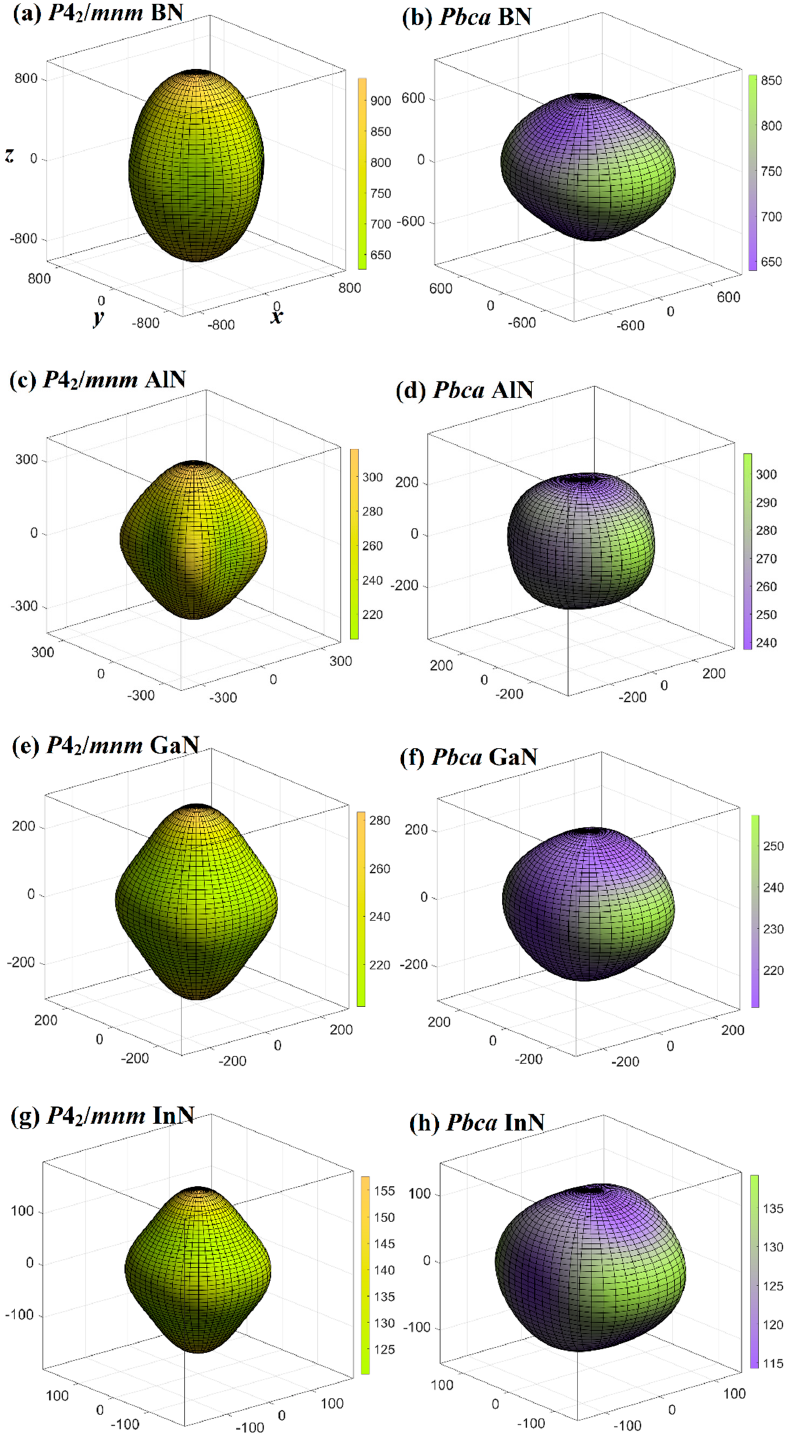
Figure 5. Three-dimensional contour plots of the Young’s modulus for BN ( a ), AlN ( c ), GaN ( e ), and InN ( g ) in the P 4 2 / mnm phase; and three-dimensional contour plots of the Young’s modulus for BN ( b ), AlN ( d ), GaN ( f ), and InN ( h ) in the Pbca